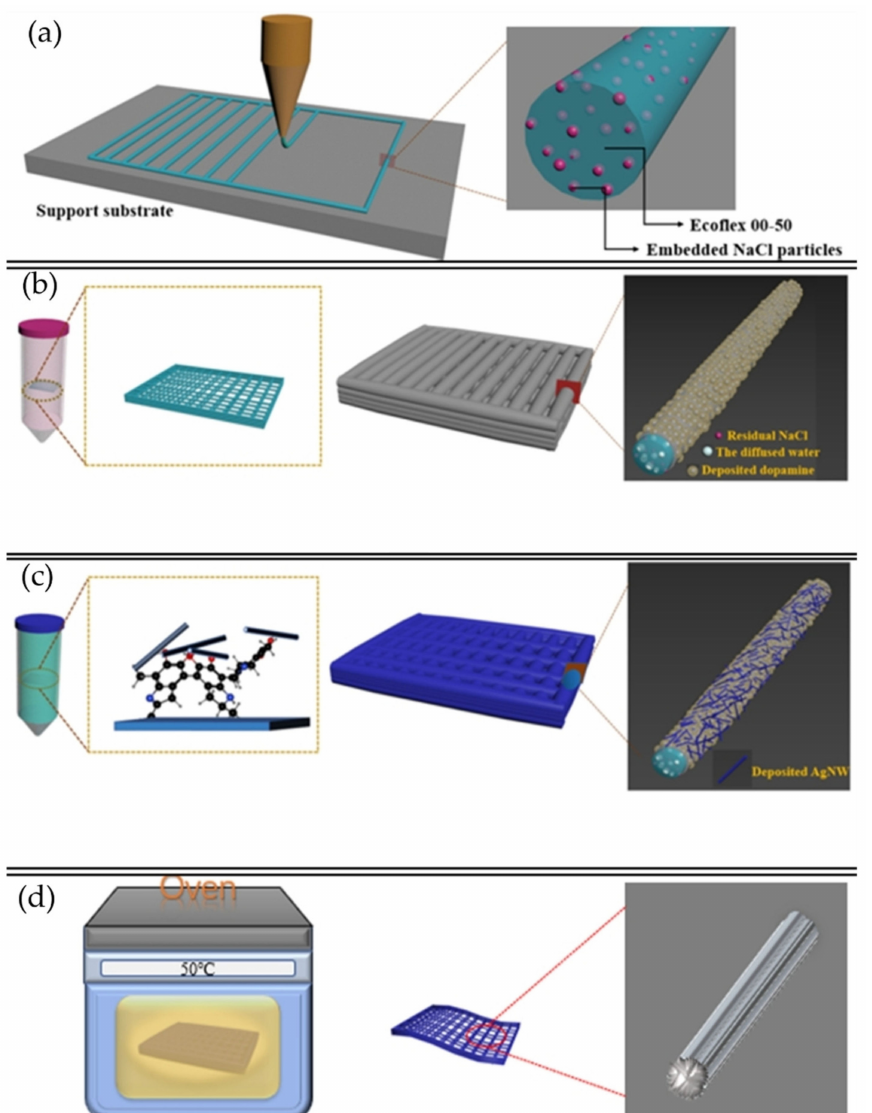
Figure 39. Schematic description of the fabrication process of stretchable elastomer sensors. ( a ) For- mation of structures by 3D printing. ( b ) Dopamine treatment via immersion in an aqueous solution. ( c ) Deposition of AgNW on the dopamine-coated sample and ( d ) formation of rough structures after remotion of residual water. Reproduced with permission from reference [153]. Copyright 2022, Elsevier